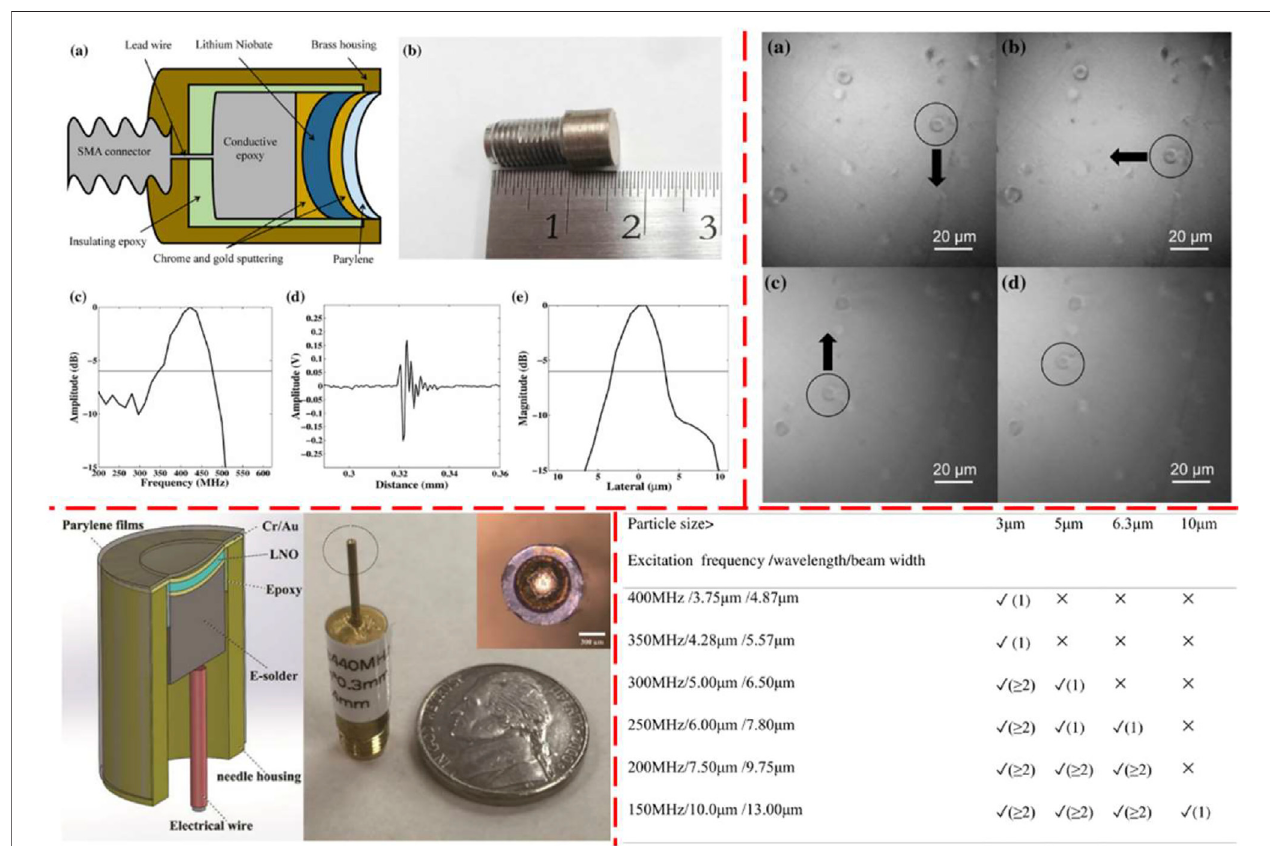
FIGURE 2 | 400 MHz ultra-high frequency ultrasonic transducer structure and performance (top left) ; 500 MHz ultra-high frequency ultrasonic transducer structure (bottom left) ; red blood cell acoustic tweezers capture process under microscope (top right) ; acoustic tweezers capture particles under different excitation results (bottom right)